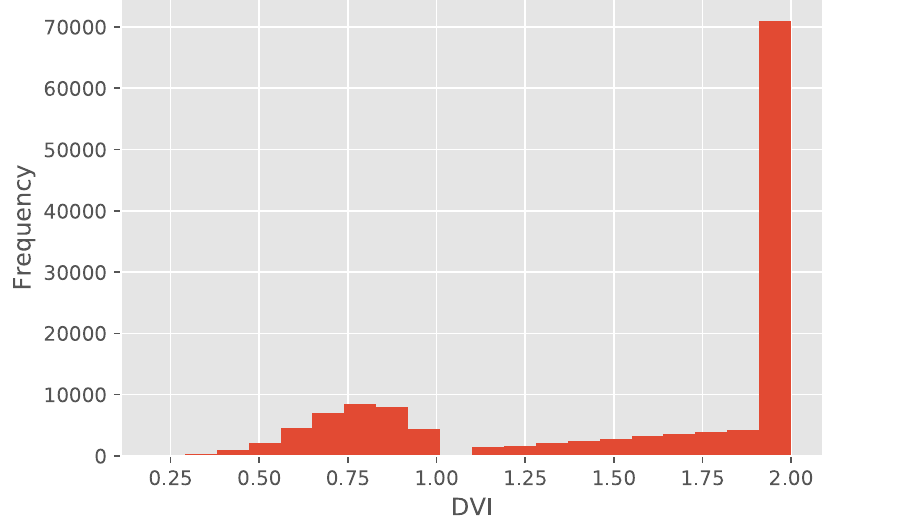
Fig 2. Histogram of final DV I of all datasets. In total, 48% of datasets do not reach 2.0 of DV I .